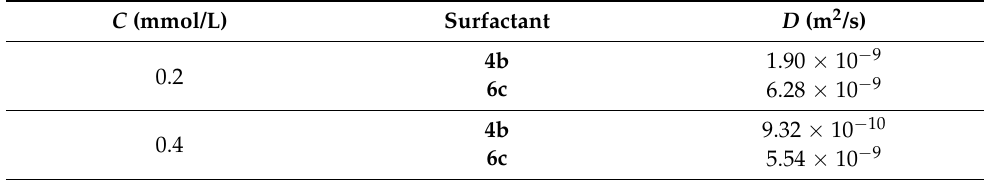
Table 4. Diffusion coefficients of 4b and 6c .